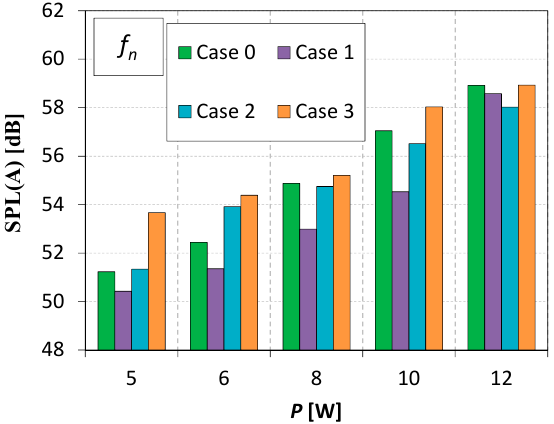
Figure 8. SPL(A) of SJA at different power.